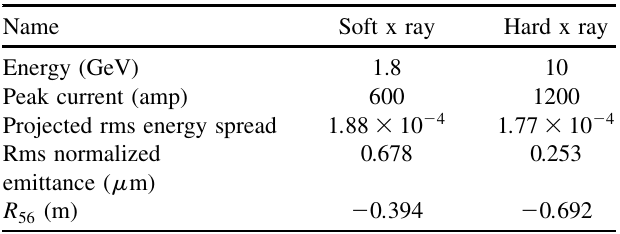
TABLE IV. Beam parameters for eRHIC FEL after the bunch compressor.